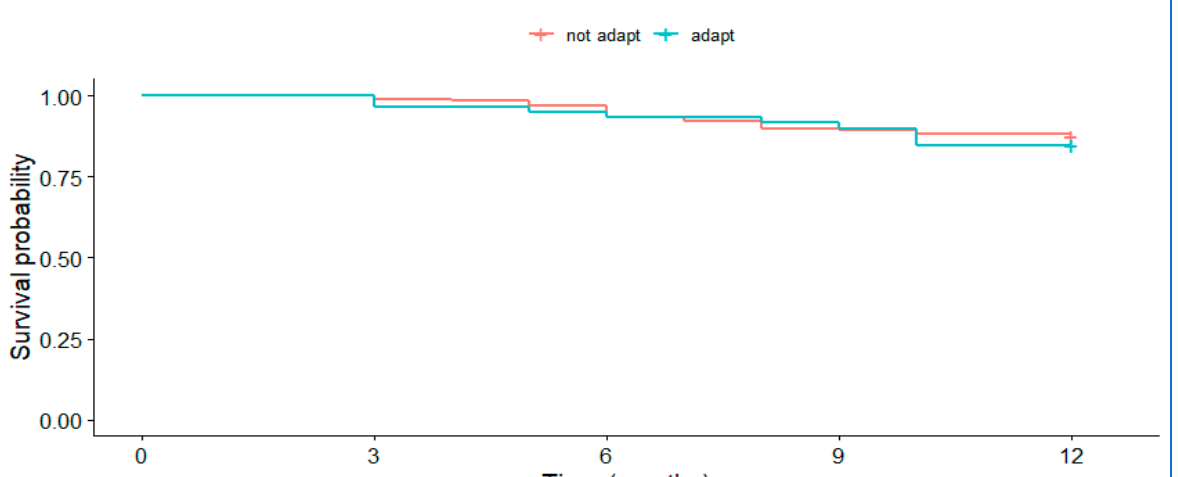
Figure 3. Adaptation in research/technology (Ad16).